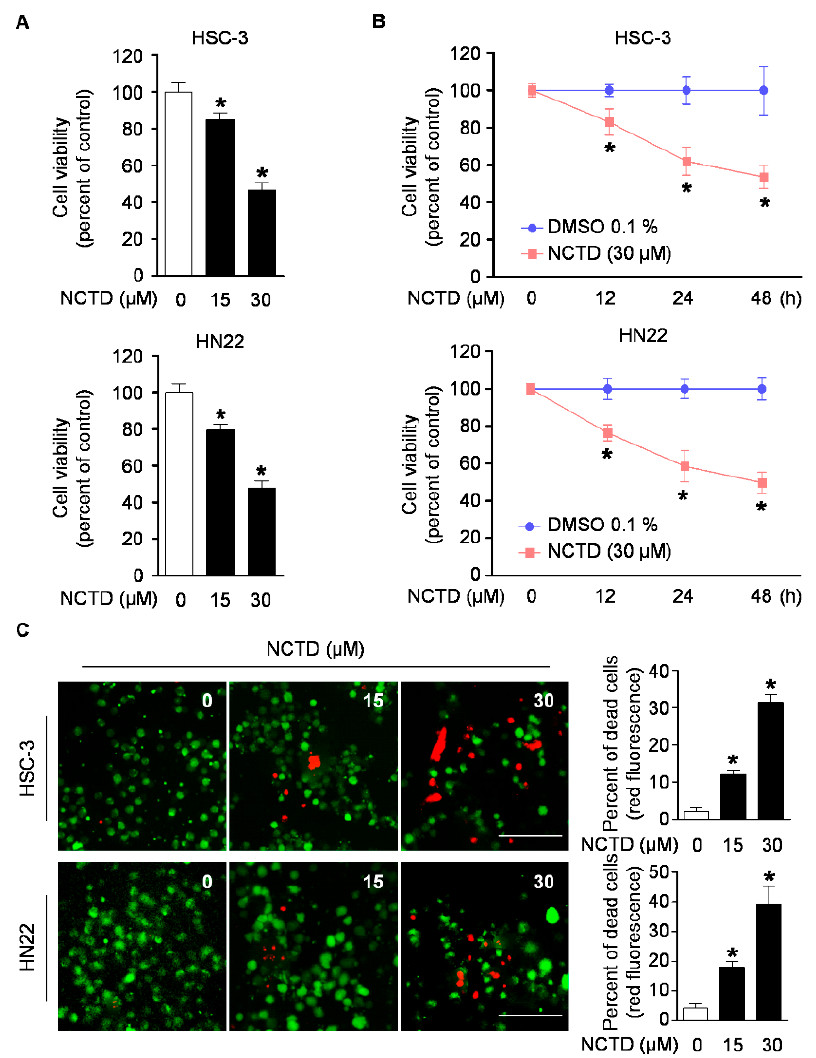
Figure 1. E ff ects of Norcantharidin (NCTD) on cell viability in human oral squamous cell carcinoma (OSCC) cell lines. HSC-3 and HN22 cells were treated with dimethyl sulfoxide (DMSO) or certain concentrations of NCTD for 48 h or 30 µ M NCTD for 12, 24, or 48 h. ( A , B ) Cell viability was analyzed using a trypan blue exclusion assay. ( C ) Cytotoxic e ff ect of NCTD was detected by a live / dead assay kit. For the fluorescence microscope images, live cells were stained with Calcein AM (green) and dead cells were stained with EthD-1 (red) (scale bar, 100 µ m). The percentage of dead cells was quantified. Graphs represent the mean ± SD of three independent experiments, and significance compared with the control group is indicated (*).